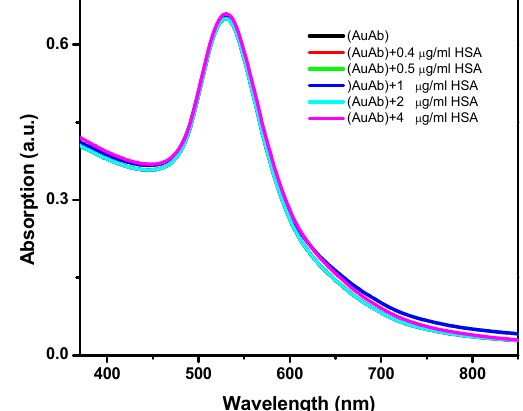
Fig. 6. UV-Vis spectra of AuNPs-antibody conjugates after addition of different concentrations of HSA protein